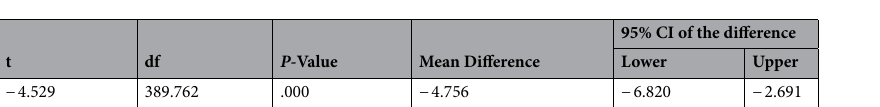
95% CI of the difference Lower Upper